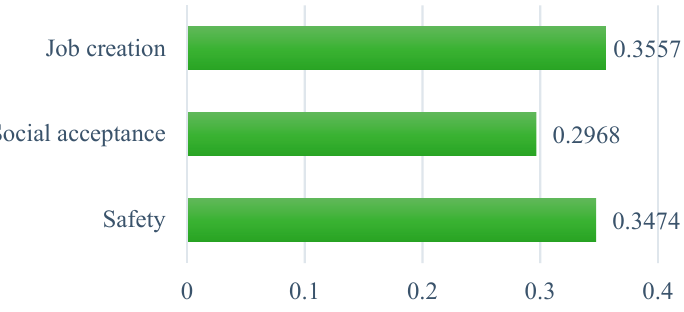
Figure 10. Priority weights of the social sub-criteria.